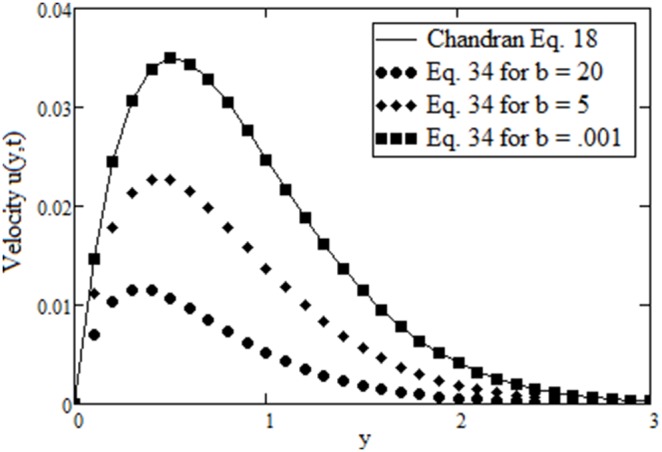
Comparison of velocity  in Eq. (37) with Eq. (18) in Chandran et al.
[9].